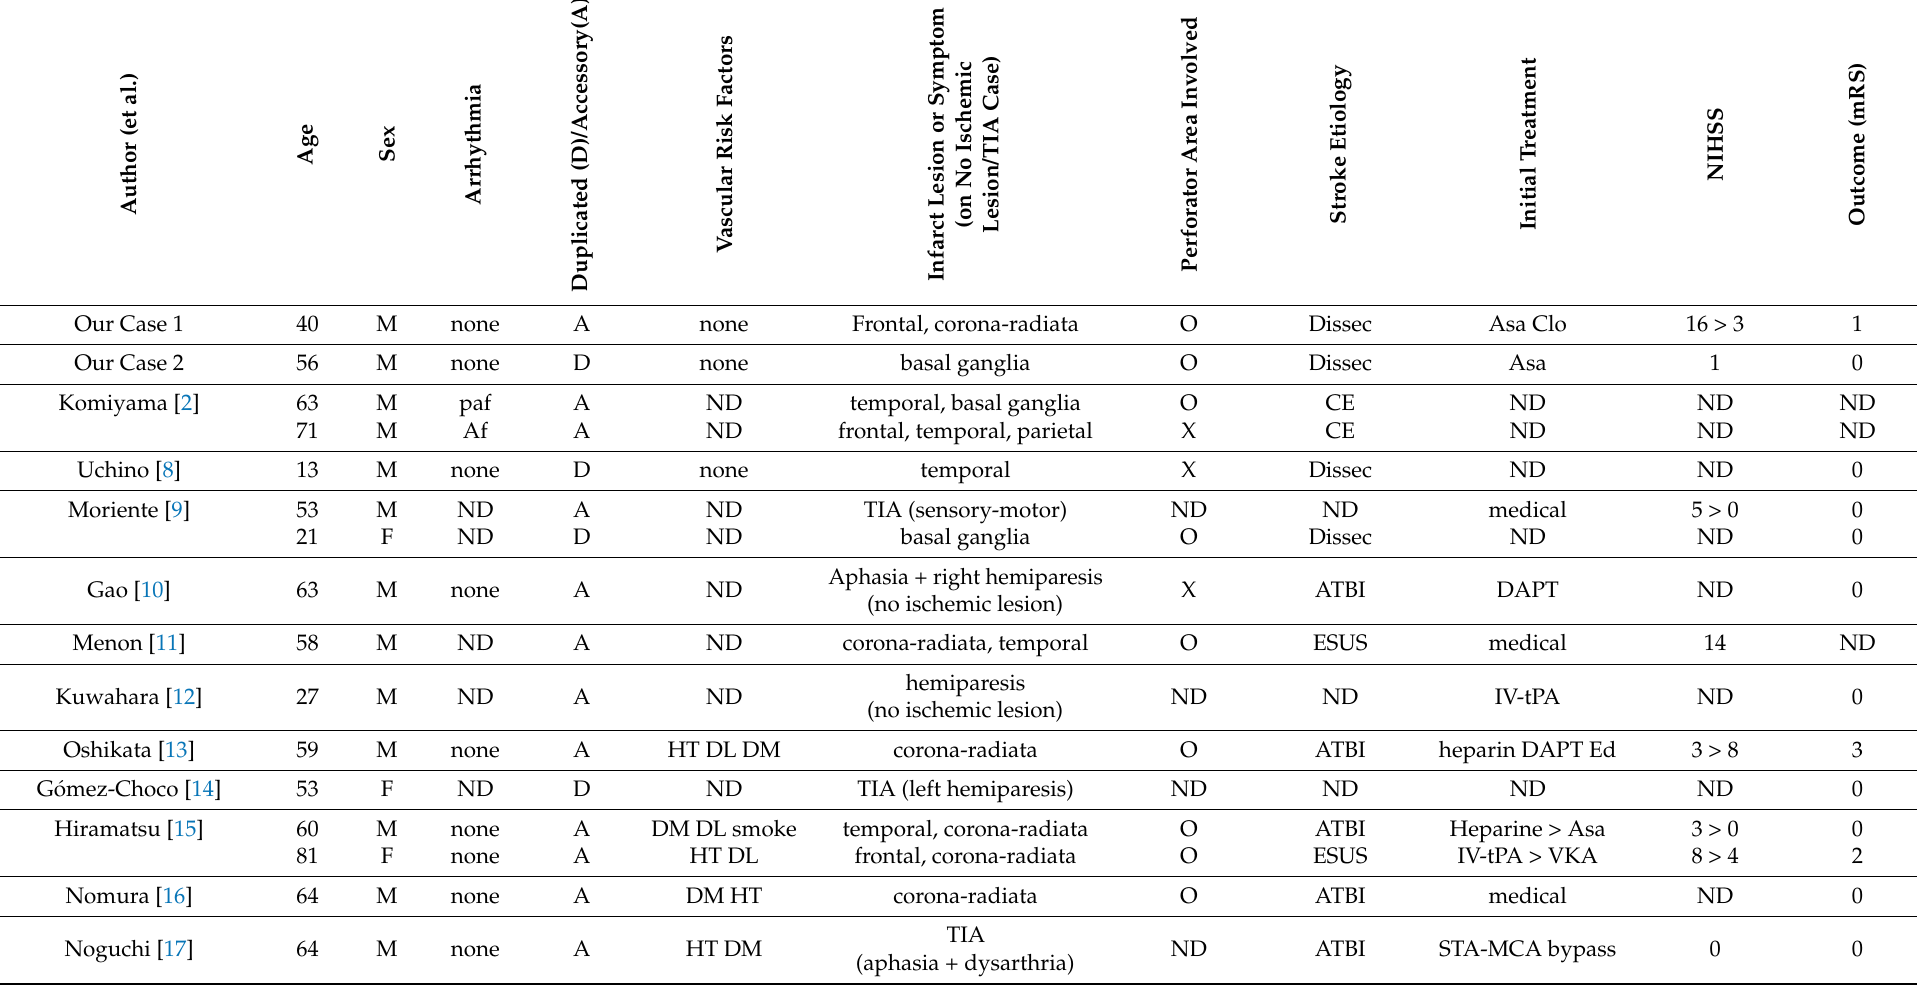
Table 1. Clinical features duplicated/accessory MCA-related cerebral